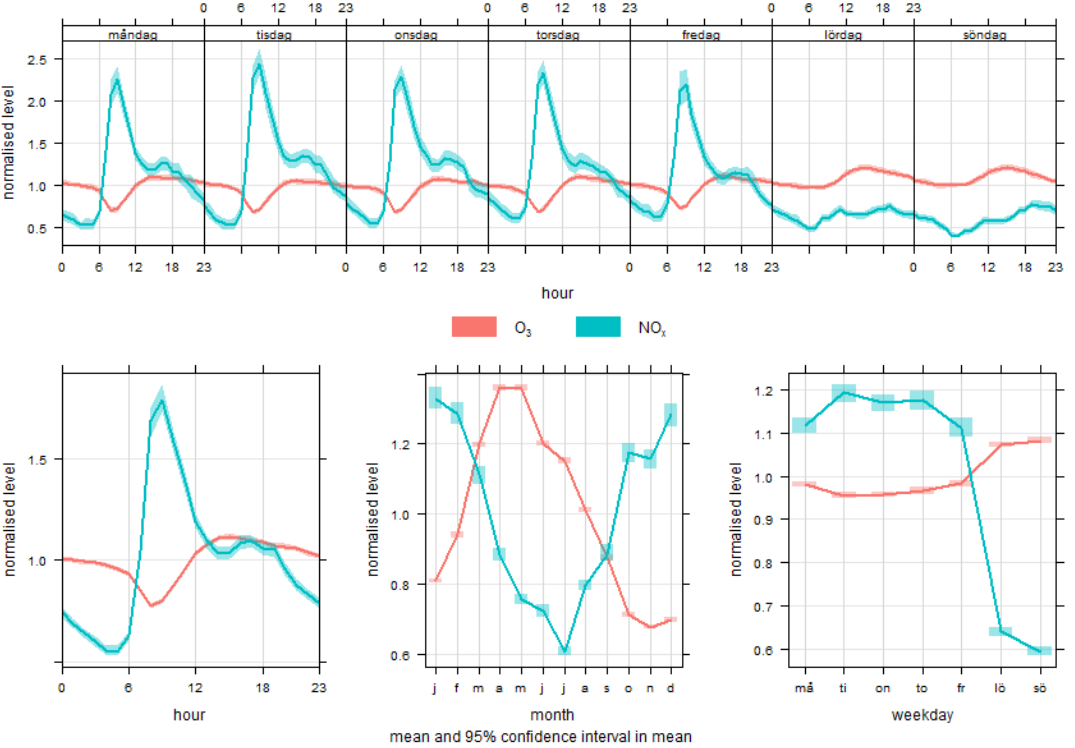
Figure A1. Mean normalized temporal variations in the concentrations of ozone and NOx in urban background of central Stockholm, based on measured hourly mean values for the period 2003–2013. Comparison Between Calculated and Modelled Concentrations